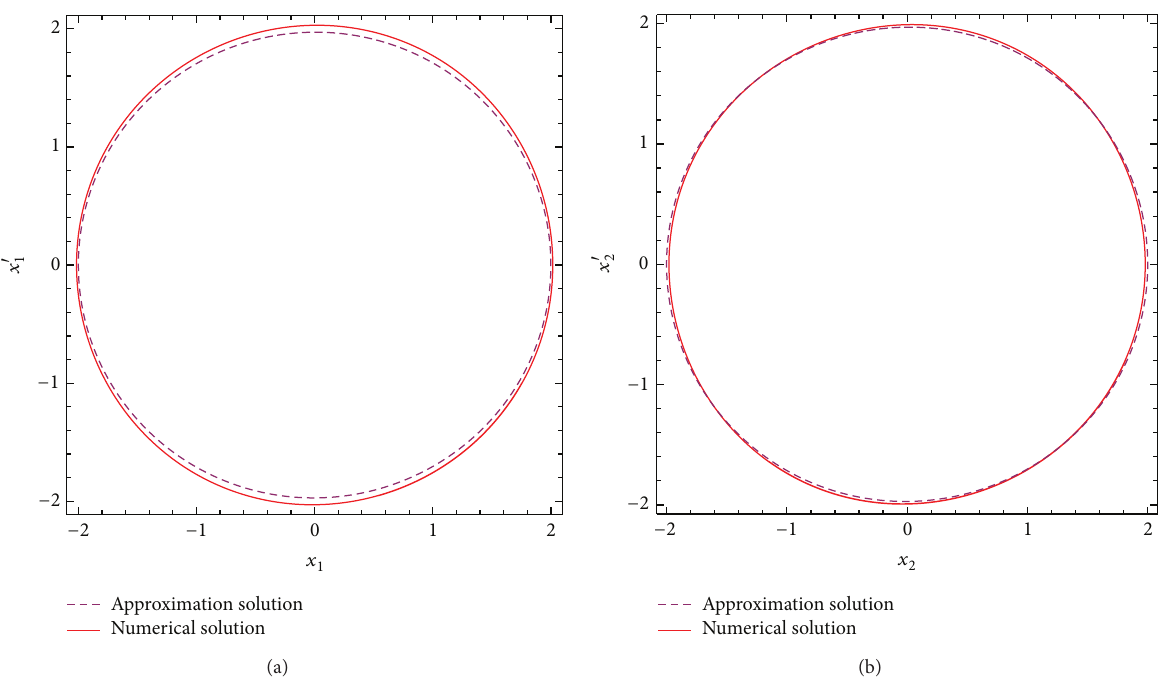
Figure 1: Comparison of the phase portrait curves of the forth-order approximation with the numerical integration method.